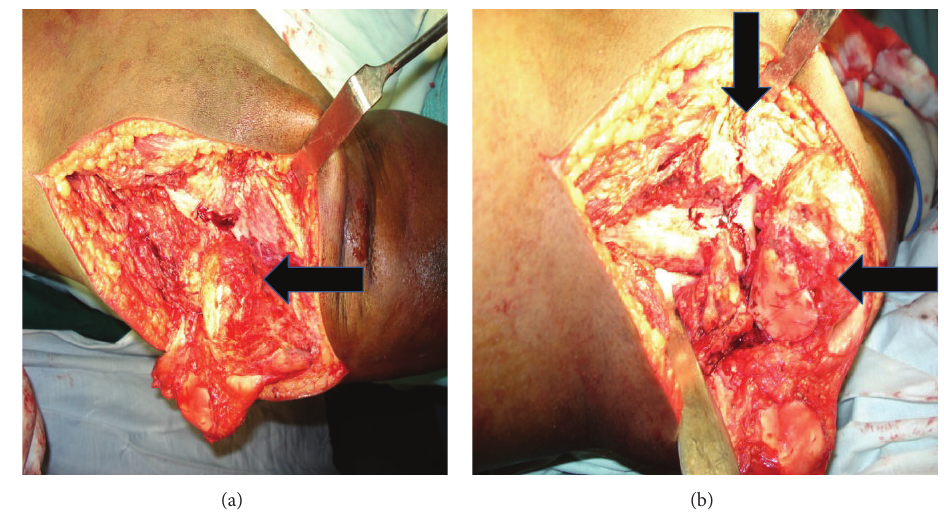
Figure 2: Chondrolysis of femoral and tibial